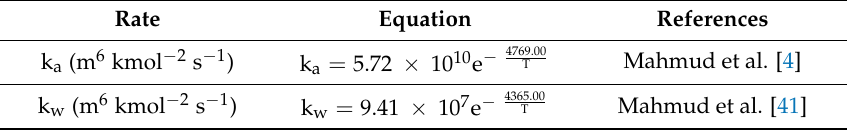
Table 6. List of rate expressions used for Termolecular mechanism. Rate